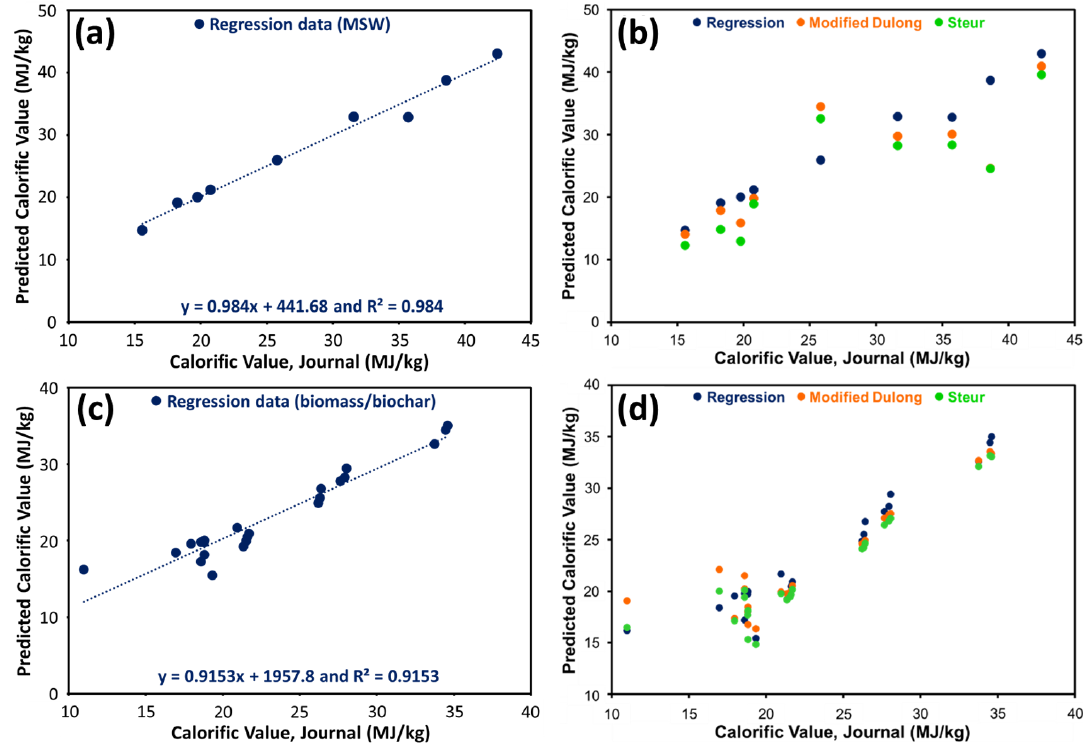
Fig. 1. Regression plot and comparison between predicted and literature calorific values for the regression, Dulong, and Steur correlations based on ultimate analysis for (a – b) MSW sample composition and (c – d) biomass/biochar sample